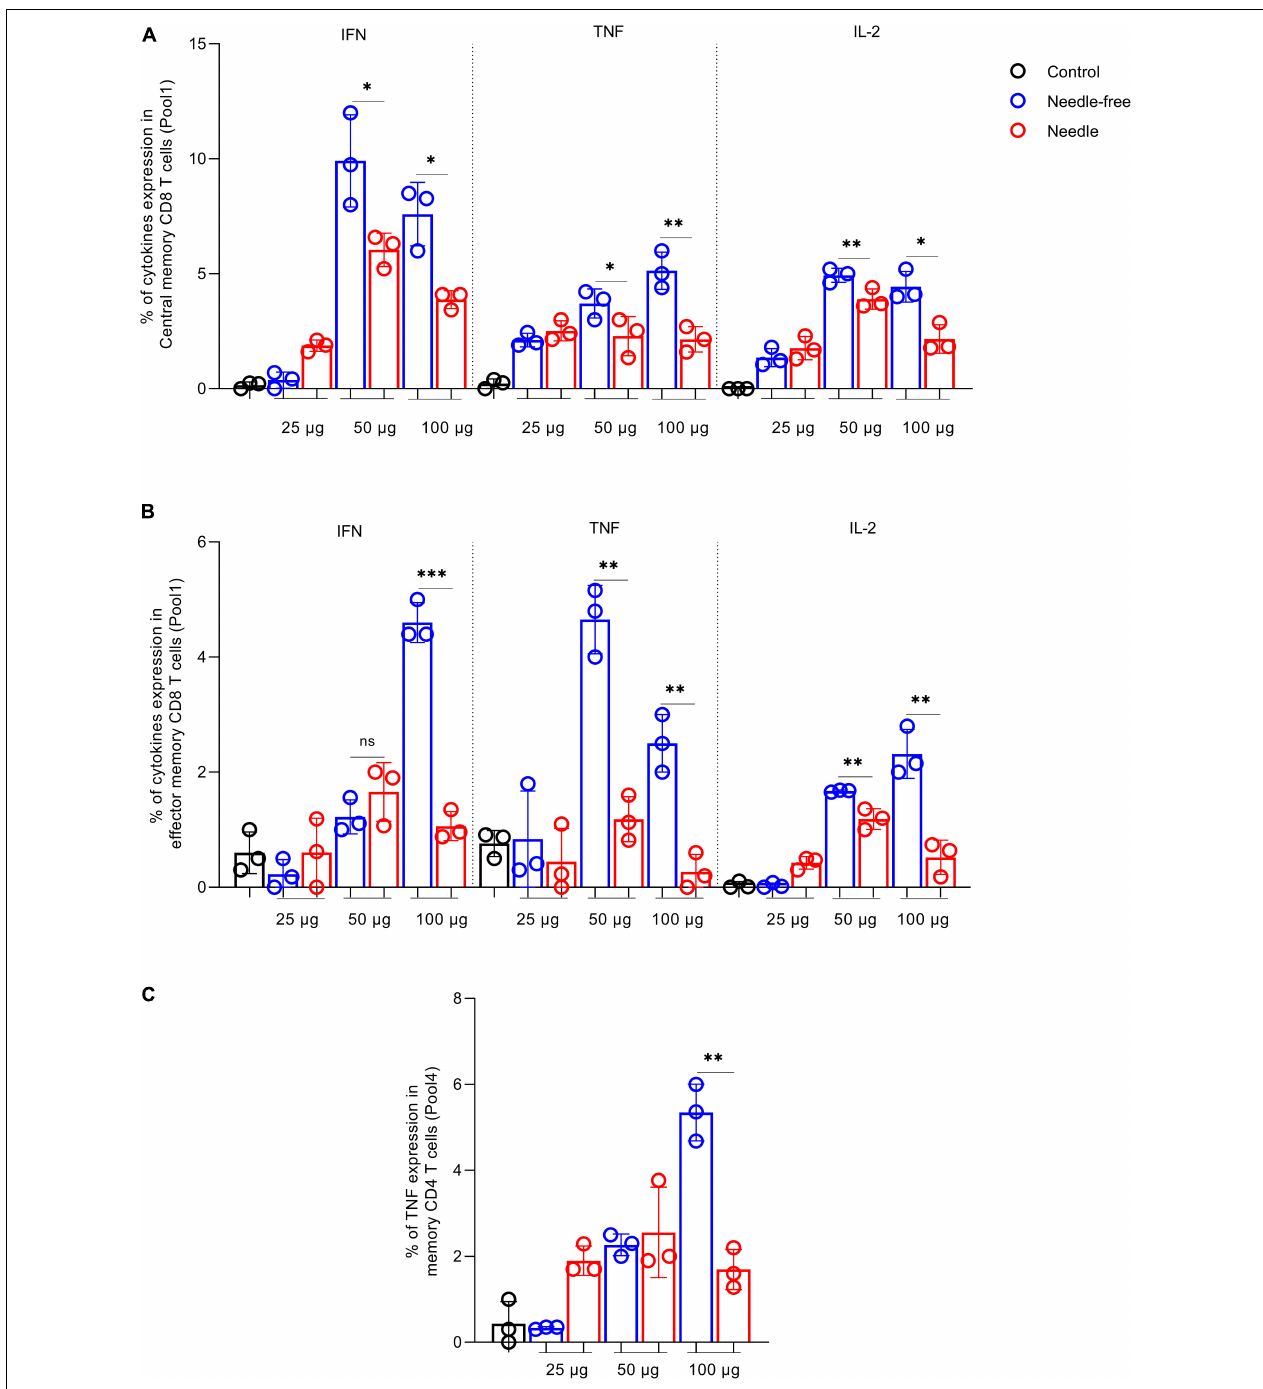
FIGURE 6 | Memory T cell response against SARS-CoV-2 S protein in BALB/c mice intramuscularly immunized with VIU-1005 using either needle-based or needle-free immunization. Intramuscularly immunized BALB/c mice with 3 doses of 25, 50, or 100 µ g of VIU-1005 plasmid at 2-week intervals using either needle injection or needle-free Tropis system were sacrificed at 12 weeks after the primary immunization, and splenocytes ( n = 3) were isolated and restimulated ex vivo with synthetic peptide pool 1 from SARS-CoV-2 S protein. Representative plots are shown in Supplementary Figure 3 . Histograms show IFN- γ , TNF- α and IL-2 on (A) live CD8 + CD44 + CD62L + central memory T cells (CD8 + TCM) and (B) effector CD8 + CD44 + CD62L − memory T cells (CD8 + TEM). (C) TNF- α expression in memory CD4 + CD44 + CD62L − T cells. Data are shown as the mean ± SD for each group from one experiment ( n = 3).